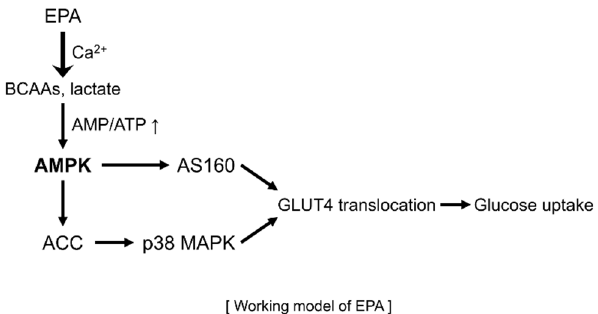
Figure 7. Schematic illustration of AMPK signaling pathway following EPA treatment in skeletal muscle cells.